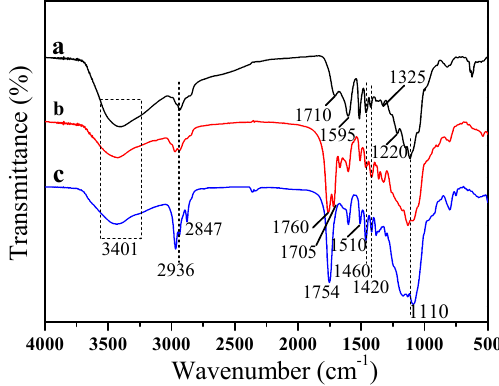
Figure 5. FTIR spectra of Ac-lignin ( a ), At-lignin ( b ), and By-lignin ( c ).